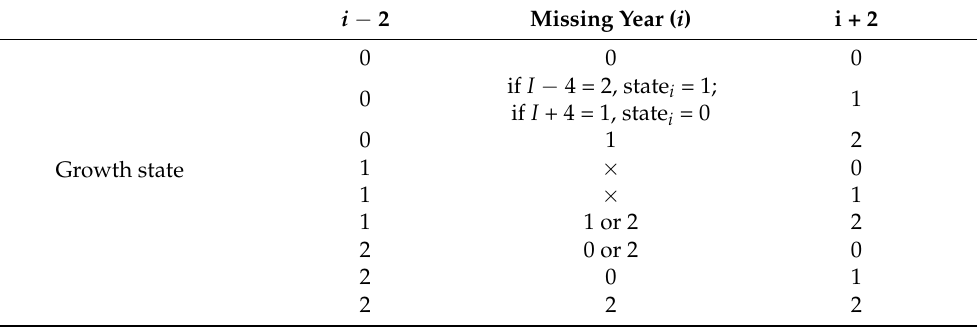
Table 2. Growth-state prediction for missing years based on the three-stage growth process over a two-year period.